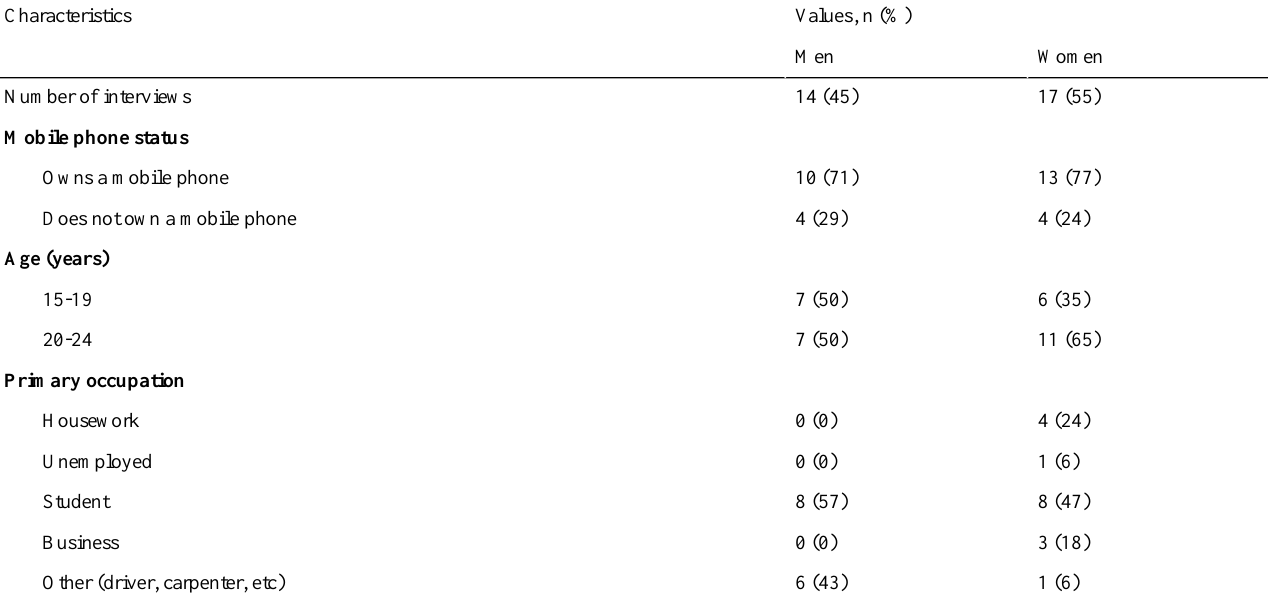
Table 1. Characteristics of 15- to 24-years-olds who participated in key informant interviews.